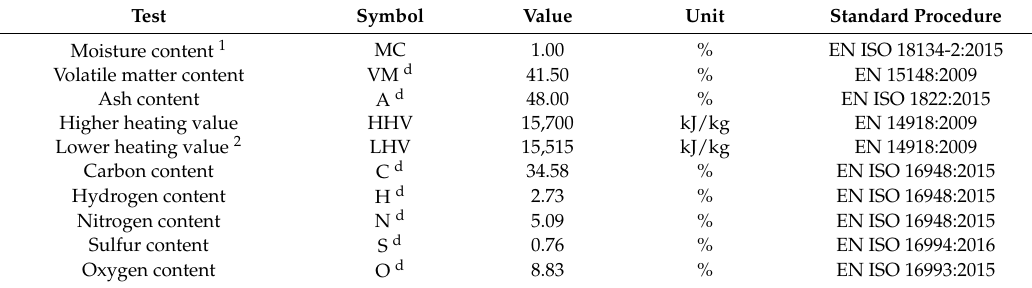
Table 4. Proximate and ultimate analysis of the torrefied sewage sludge.